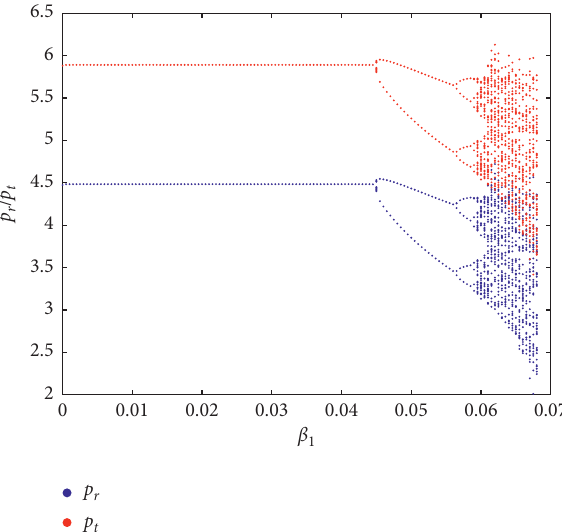
Figure 4: Bifurcation diagram of p